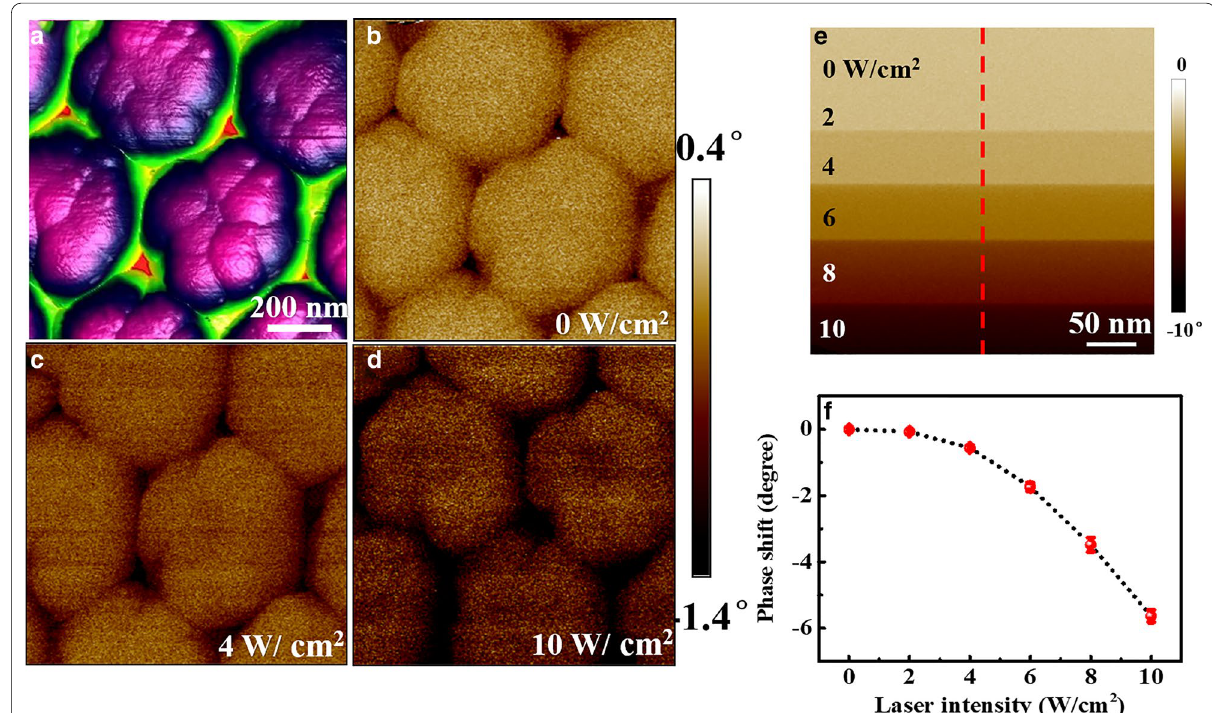
Fig. 5 The topography image of Si NWs ( a ), the phase shift images obtained at different laser intensities of 0 ( b ), 4 ( c ) and 10 W/cm 2 ( d ), respectively. e The phase shift image acquired in line scan mode on the top center of nanowire. The averaged phase shift over the scan line along the marked red curve in e is plotted in